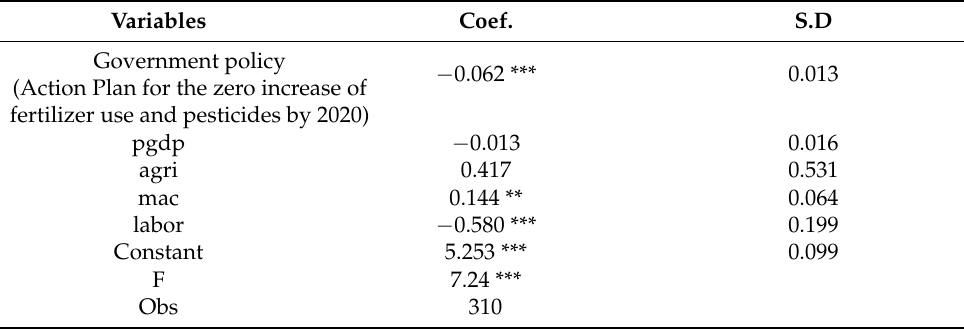
Table 3. The effect of government policy on carbon